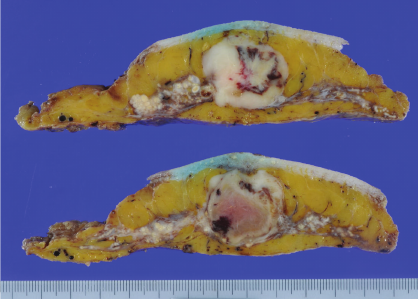
Figure 1: Gross appearance of the right breast tumor. The cut surface showed a relatively well-circumscribed nodule with a whitish tan color, representing metaplastic spindle cell carcinoma. The nodule was contiguous with the apocrine carcinoma component.